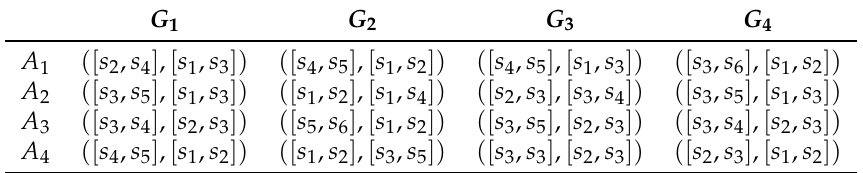
Table 2. Linguistic interval-valued intuitionistic fuzzy decision matrix (cid:101) R ( 2 ) of decision-maker D ( 2 ) . G 1 G 2 G 3